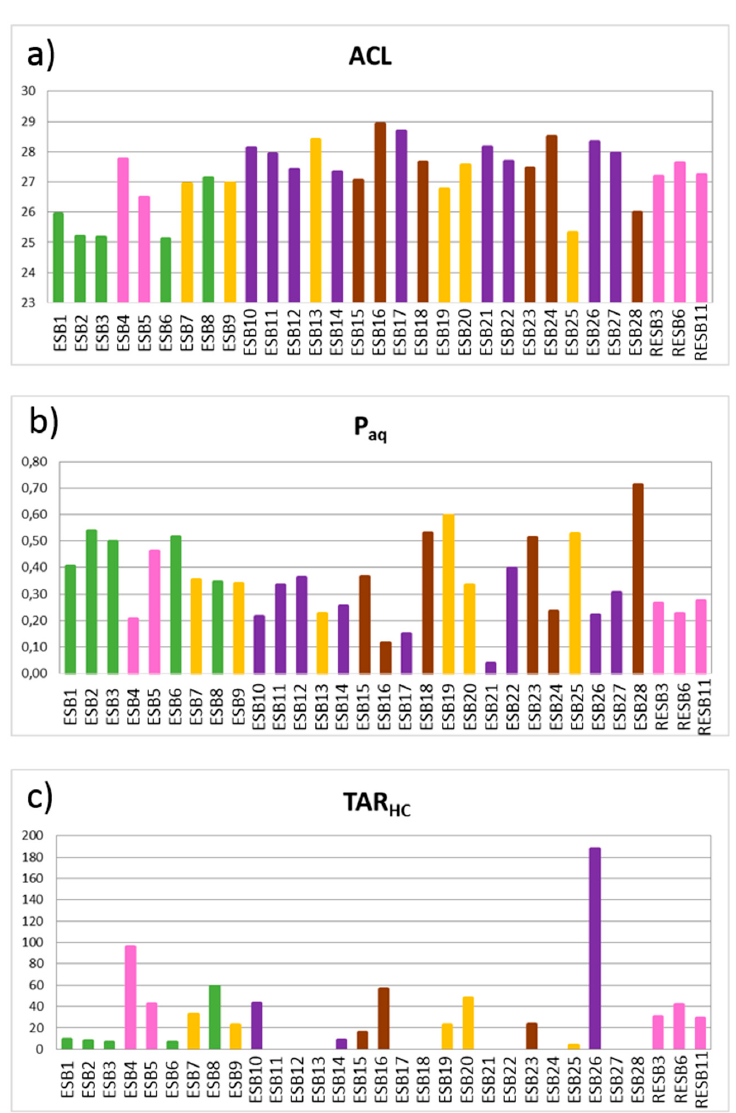
Figure 9. Projection of the proxies from the n -alkanes. ( a ) Average chain length (ACL); ( b ) Paq index; ( c ) terrigenous/aquatic acid ratio (TARHC). (Green): green clays; (Pink): pink clays; (Purple): illitic samples; (Brown): sandy samples; (Yellow): carbonatic samples.